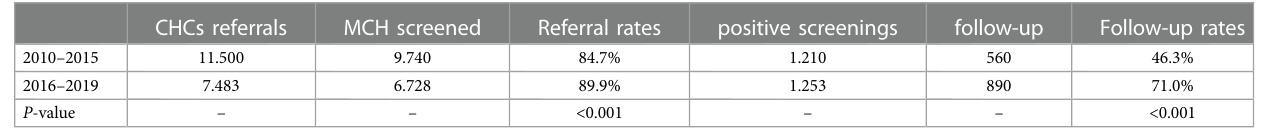
TABLE 1 Comparison of referral rates and follow-up rates between different time periods.